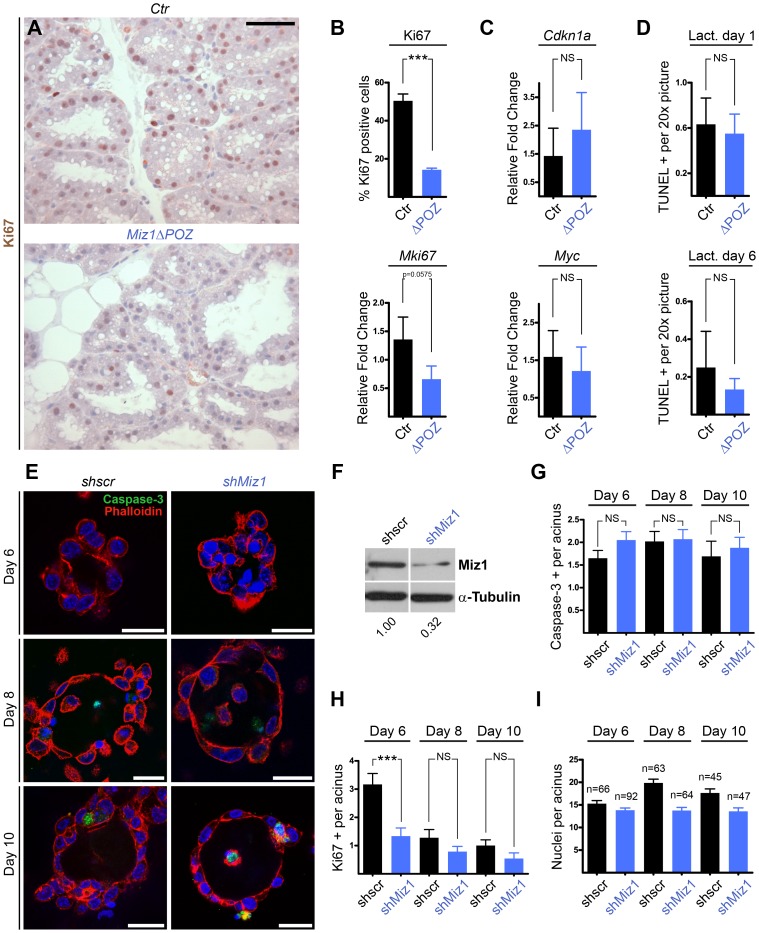
Miz1 function on proliferation and apoptosis of mammary gland epithelial cells in vitro and in vivo.(A) Ki67 immunostaining in control and Miz1ΔPOZ lactation day 6 mammary glands. (B) Ki67 labeling index (up) and quantitative RT-PCR (down) obtained from lactation day 6 samples. (C) The expression of potential proliferation regulators like Cdkn1a and Myc was measured by qRT-PCR. (D) The TUNEL assay was performed on tissue from lactation day 1 and lactation day 6, respectively. Quantifications obtained from 20x pictures are shown (at least n = 3 per genotype and time-point). (E) Representative confocal microscopy pictures of acinar structures formed 6, 8 and 10 days after seeding shscr and shMiz1 transfected HC11 cells onto Cultrex-coated coverslips. Nuclei were stained with Hoechst (blue), actin filaments with Phalloidin-TRITC (red) and apoptotic cells by cleaved Caspase-3 immunostaining (green). (F) Western Blot showing the knock-down of Miz1 in shMiz1 HC11 cells. Numbers indicated are fold changes of band intensities obtained by densitometry (see Materials and Methods). Acinar cell apoptosis and proliferation were quantified by analysis of cleaved caspase-3 (G) and Ki67 (H) positivity in double immunofluorescence confocal microscopy pictures. (I) Quantification of the number of nuclei per acinus in shscr and shMiz1 transfected HC11 cells. Data from two independent experiments were merged and the total number of acini analysed is indicated. See Materials and Methods for experimental details. Scale Bar in A: 50 µm; E: 25 µm.